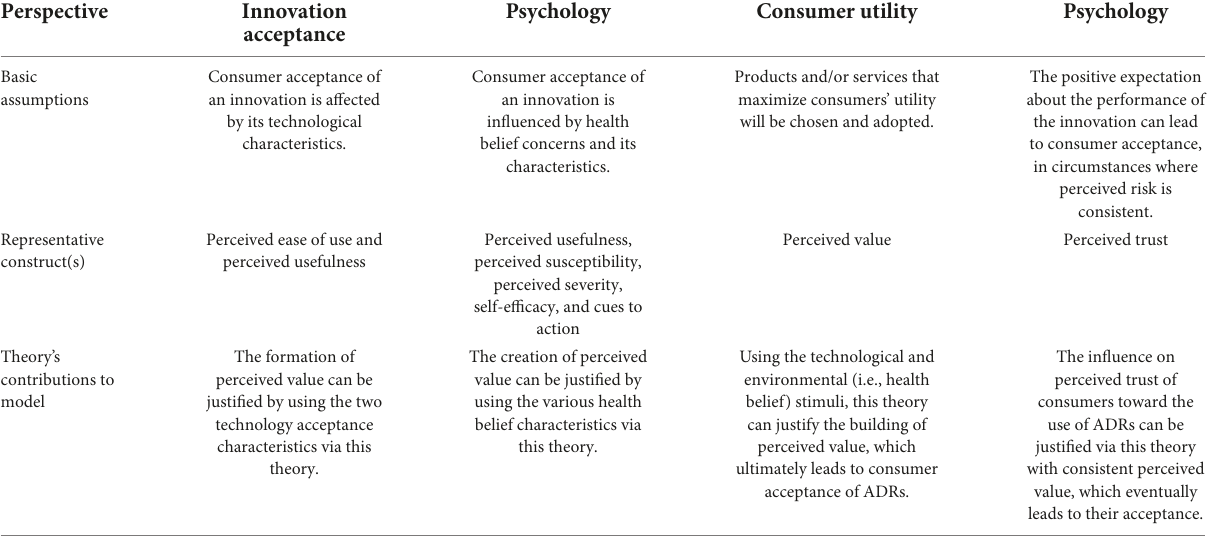
TABLE 1 Appraisal of behavioral theories that influence consumer acceptance of